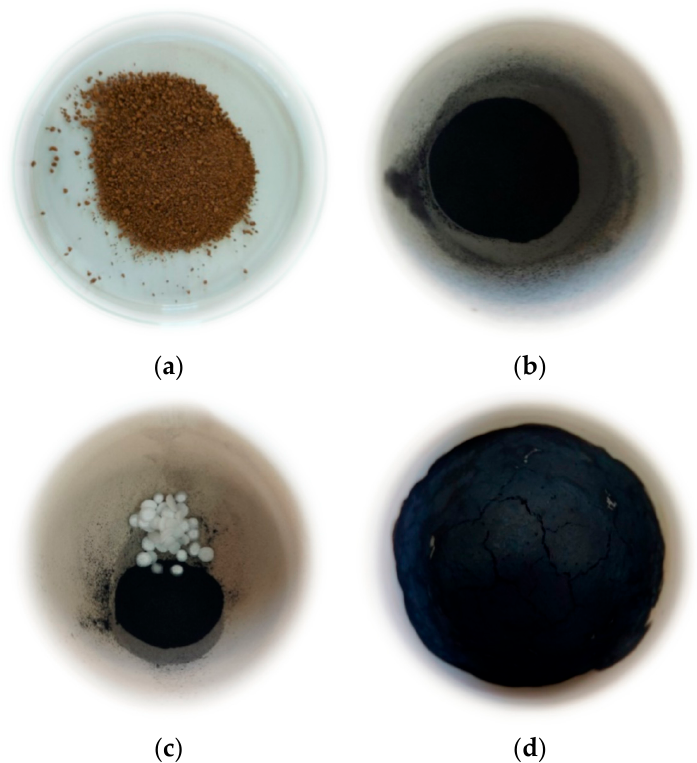
Figure 1. Process of preparing the biomass-derived-ACs material: ( a ) waste tea leaf, ( b ) pre-carbonizing of waste tea leaf at 600 °C, ( c ) grinding the resultant carbon material with KOH, and ( d ) carbonizing the formed mixture at 600 °C.